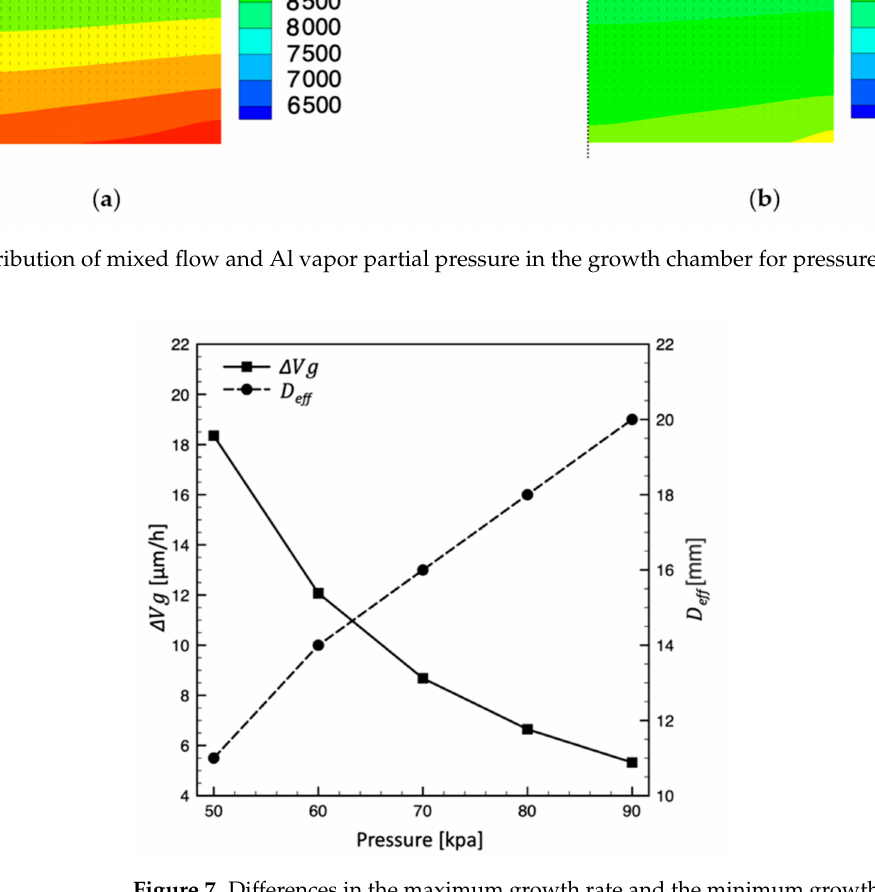
Figure 7. Differences in the maximum growth rate and the minimum growth rate ( ∆ V g ) and effective diameter D eff with different